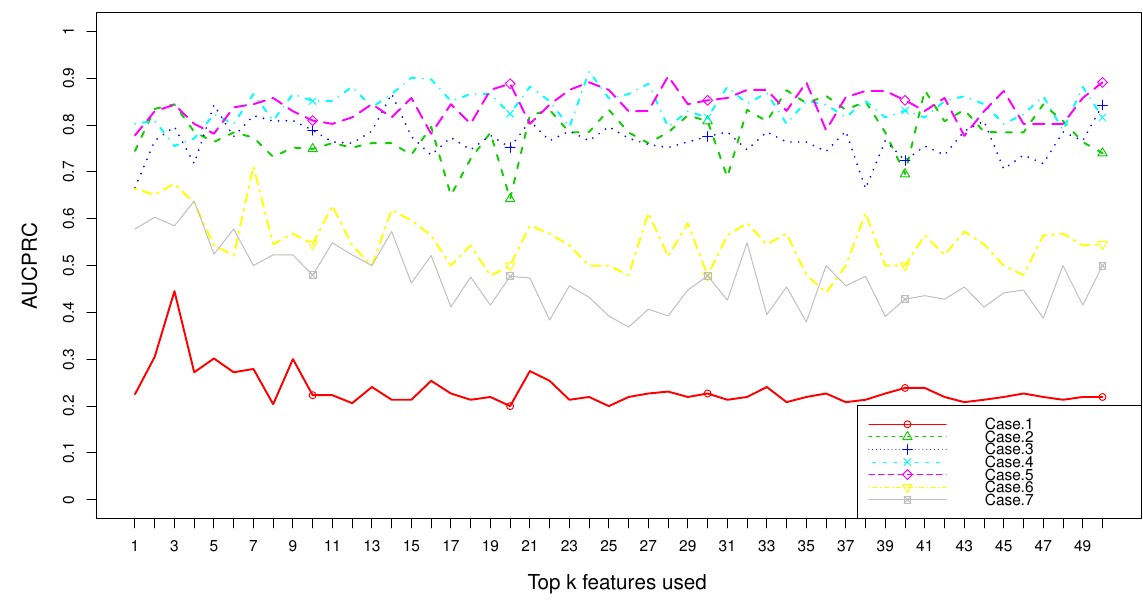
Figure 9. AUCPRC when top k features are used with the dataset “CHD2-2” on seven cases.